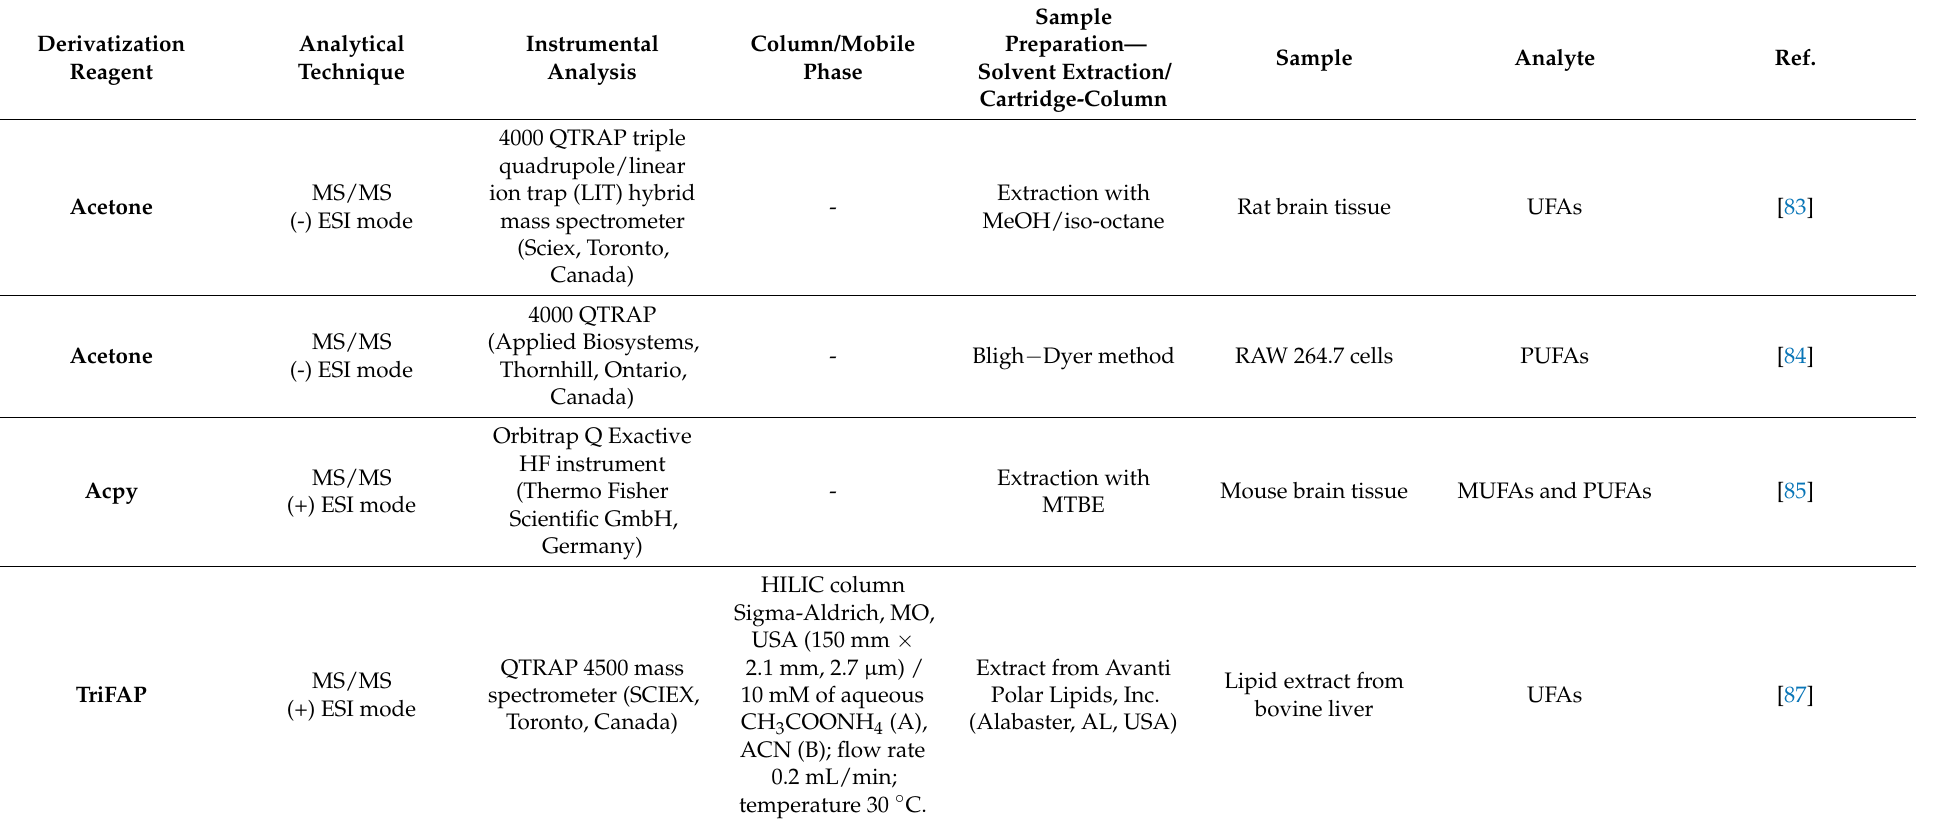
Table 2. Summary of UFA derivatization reagents and their